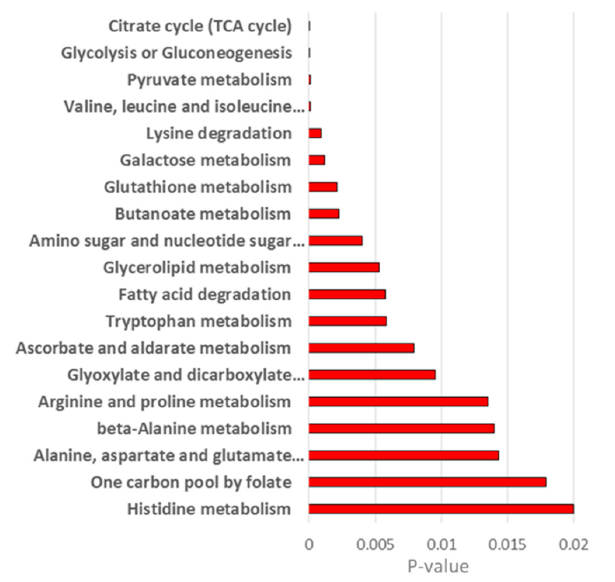
Figure 7. Metabolic pathways with the most significant enrichment for proteins found in EVs from LN18 but not EVs from U118 cells and metabolites showing different concentration between these two groups of EVs (Figure 6).